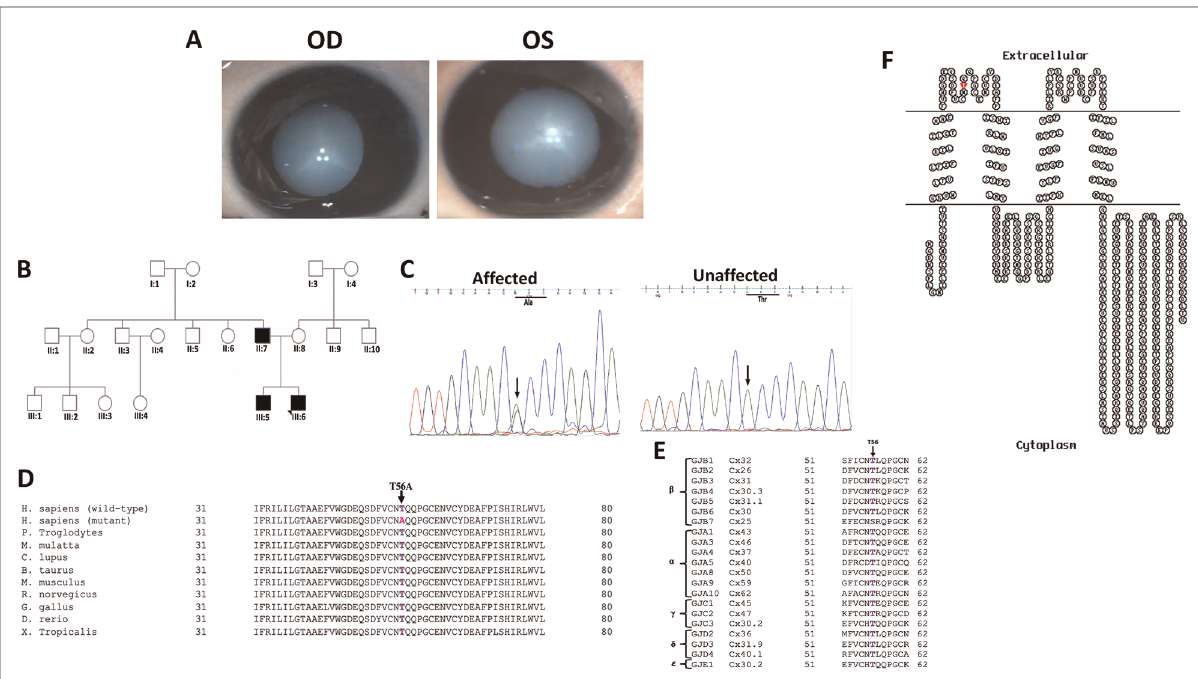
FIGURE 1 ( A ) Clinical photographs (OD and OS) of the proband (III:6) of the PC-04 family indicating total cataract. ( B ) Pedigree of an autosomal dominant congenital cataract family indicating three affected individuals in two generations. The proband is indicated with an arrow. Squares and circles symbolize male and female individuals, respectively. ( C ) Electropherograms of a part of the reverse strand sequence of exon 2 of GJA8 in the affected individual (III:6). Arrow indicates the nucleotide at which heterozygous change (AG) occurred that resulted in c.166A>G (p.T56A) in all the affected individuals. Also shown is a part of reverse strand sequence of exon 2 of GJA8 in an unaffected individual (II:8) indicates wild-type (AA) genotype. ( D ) Multiple amino acid sequence alignment (NCBI HomoloGene) of GJA8 indicating conservation of threonine [T] (shown in purple) at position 56 as indicated by an arrow in different species. Mutant sequence [ Homo sapiens (mutant)] (replacement of threonine [T] by alanine [A] at 56 position) in the affected members of the present analyzed PC-04 family is highlighted in pink. ( E ) Threonine at position 56 (indicated by an arrow) is also highly conserved in the members of different groups of human gap junction proteins (connexins) except in one of the β group connexin, that is, GJB7 . ( F ) The membrane topological structure of GJA8 was generated by TOPO2 software (http://www.sacs.ucsf. edu/TOPO2/). The mutation p.T56A (indicated by red dot) is located in the fi rst extracellular